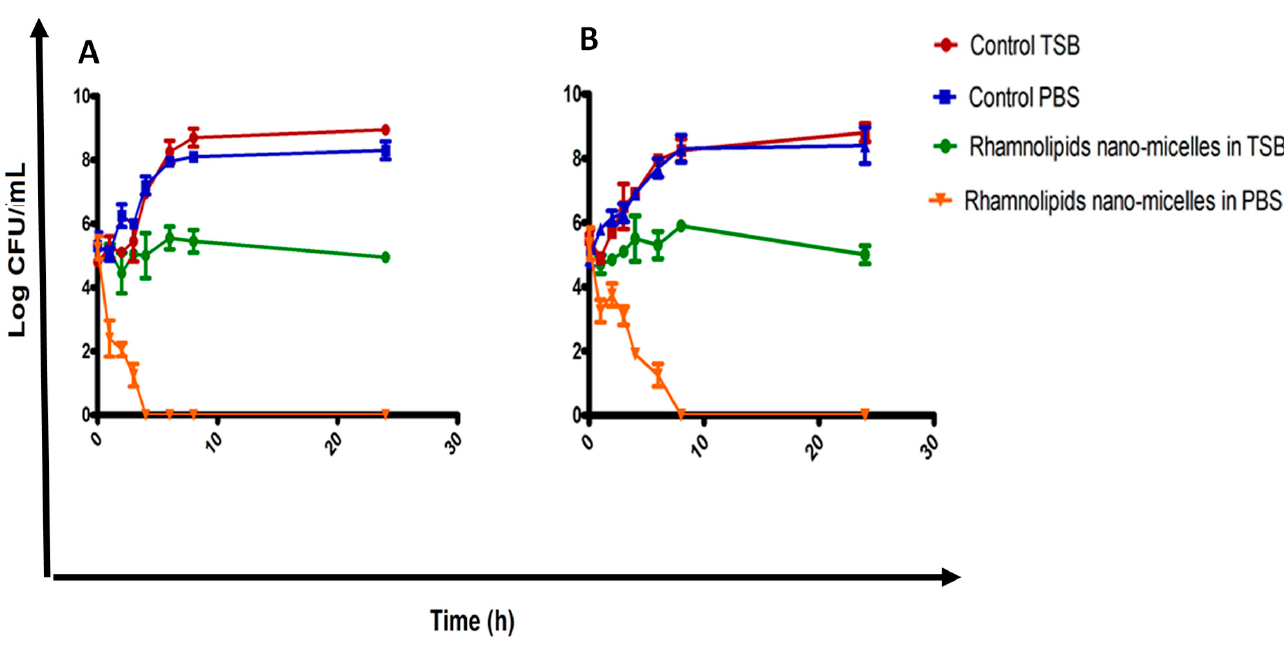
Figure 3. Time–kill curve of antibacterial activity of the rhamnolipid nano-micelles solution at its MIC value against ( A ) S. aureus and ( B ) A. baumannii ; each time point is the average of two independent experiments with three replicates each.